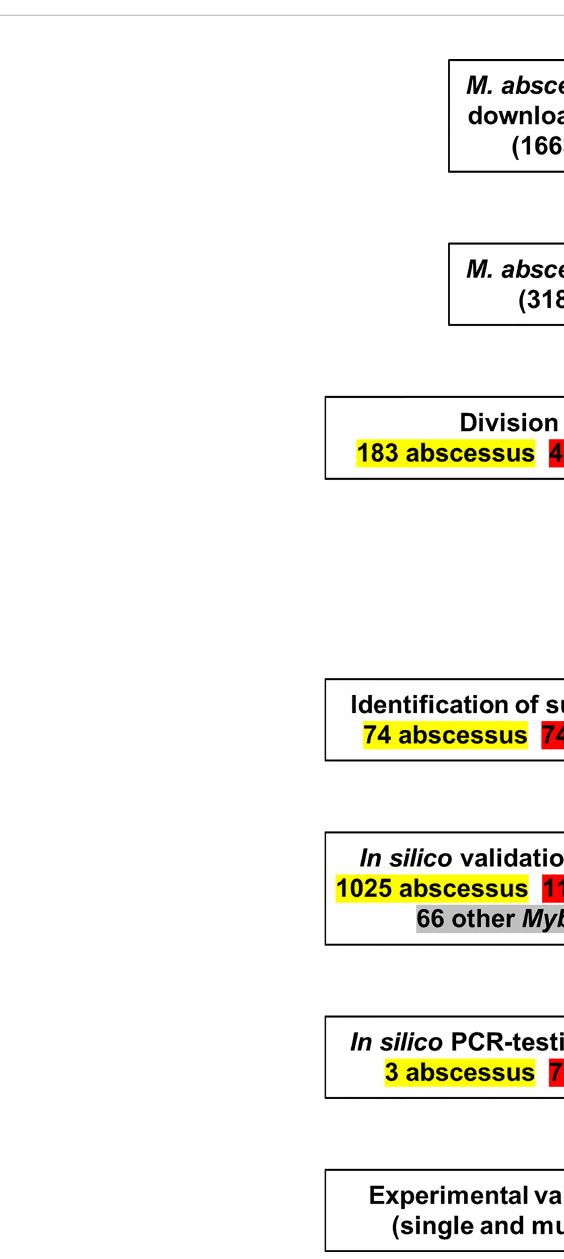
( Supplementary Table S1 ) was based on core genome single nucleotide polymorphisms identi fi ed using ParSNP with the “ -a 13 -x ” settings as described elsewhere (Pornsukarom et al., 2018). Isolates were assigned to the three MABC subspecies based on their placement on the core genome SNP and core genome MLST phylogenetic trees. Genomes were subsequently annotated